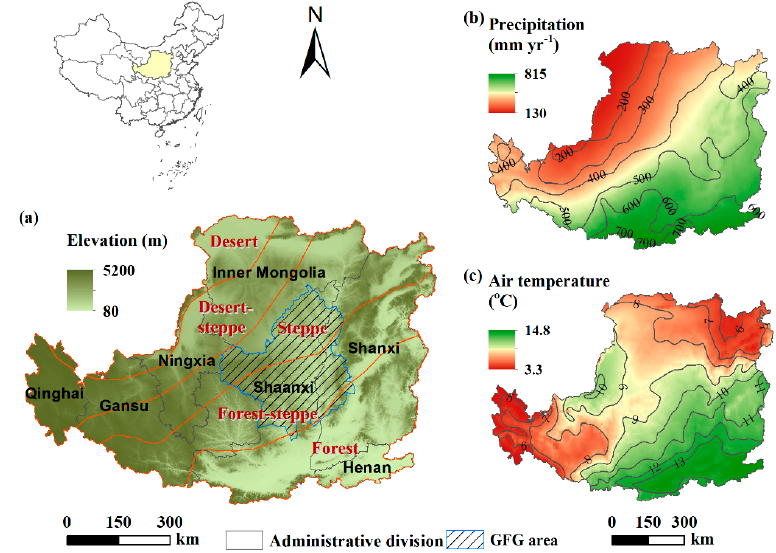
Figure 1. ( a ) Location and elevation of the Chinese Loess Plateau (CLP). Grey lines represent boundaries of administrative divisions in this region. Orange lines represent boundaries of five vegetation zones. Blue polygon with black slashes represents the main areas implemented with the Grain for Green (GFG) project in the CLP [10]. ( b , c ) Spatial distributions of ( b ) annual precipitation and ( c ) annual mean air temperature in the CLP averaged over 2000–2014. The gray lines in panel ( b ) and ( c ) are the isolines of precipitation and air temperature,